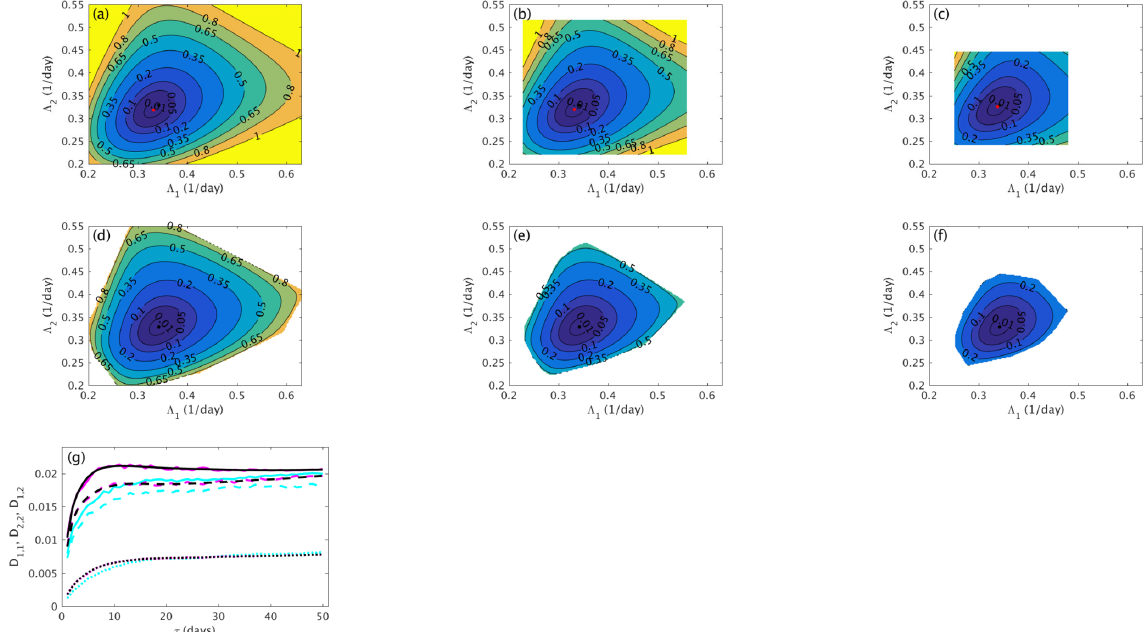
Figure 12. Joint large-deviation rate function of the first two FTLEs as estimated from the joint probability density for (a) τ = 10d, (b) τ = 15d and (c) τ = 25d; and with the Legendre transform for (d) τ = 10d, (e) τ = 15d and (f) τ = 25d. Black dots indicate the global LEs (λ 1 ,λ 2 ) ; and red dots in panels (a) , (b) and (c) indicate the maximum of the joint probability density. (g) Elements D 1 , 1 (solid), D 2 , 2 (dashed) and D 1 , 2 (dotted) of the diffusion matrix as estimated from the curvature of the probability density-based rate function (cyan), from the curvature of the Legendre transform-based rate function (magenta) and from the time series of the FTLEs